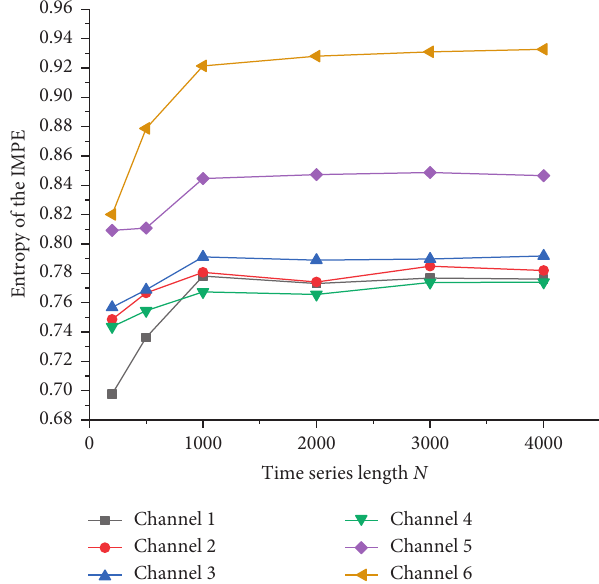
Figure 11: Entropy change diagram of dam body under different